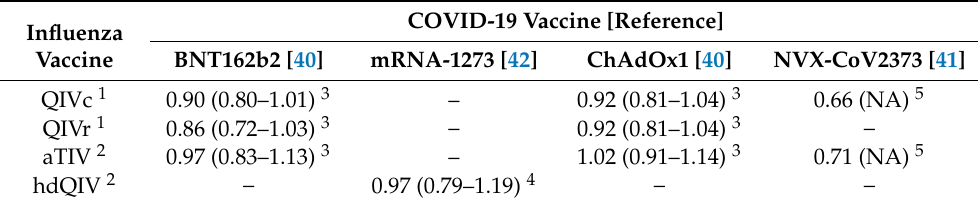
Table 3. Anti-spike IgG geometric mean ratios in COVID-19/influenza vaccine co-administration groups, as compared with groups to whom either vaccine was administered